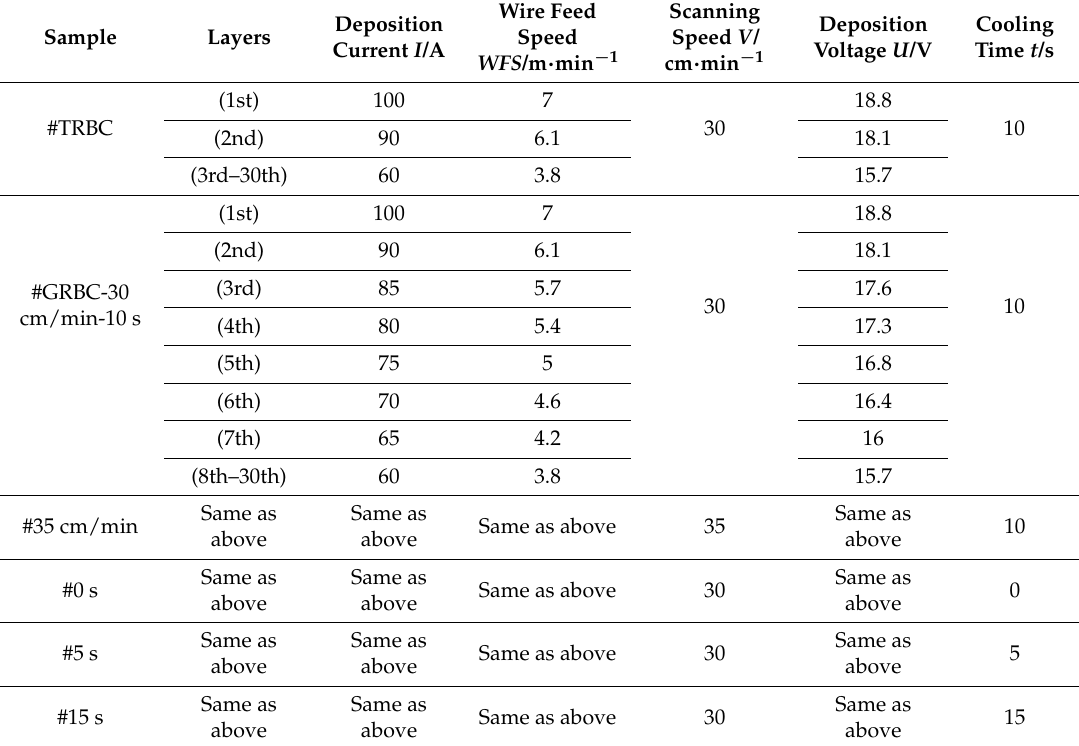
Table 2. Arc deposition experiment parameters (TRBC and GRBC represent transient and gradual reduction of bottom current,